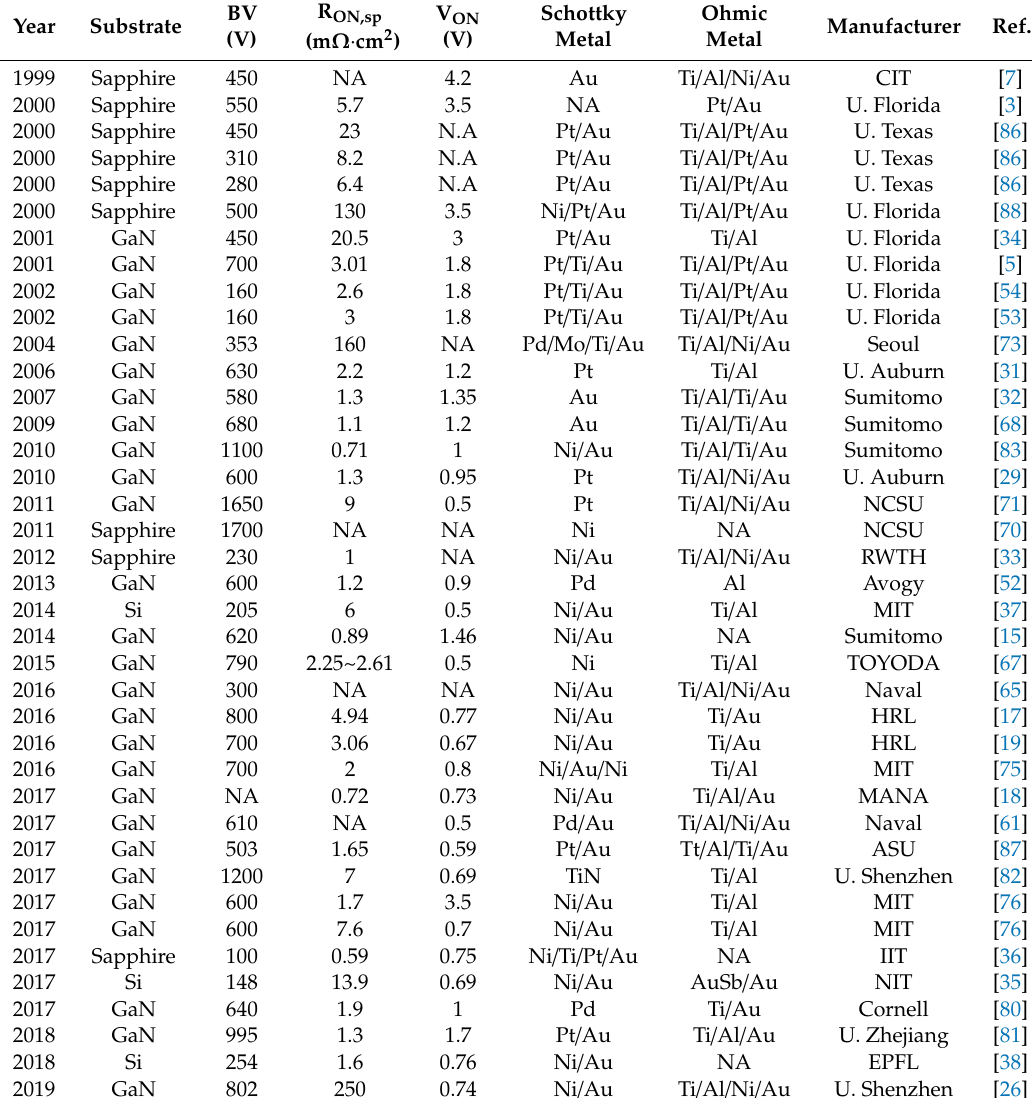
Table 2. Summary of the reported vertical GaN power SBDs in the